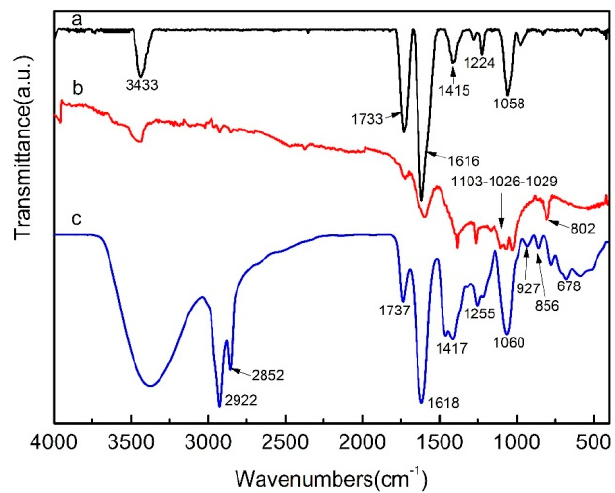
Figure 3. FTIR spectra of the GO (a), SGO (b) and SGO/WPU-3 (c).